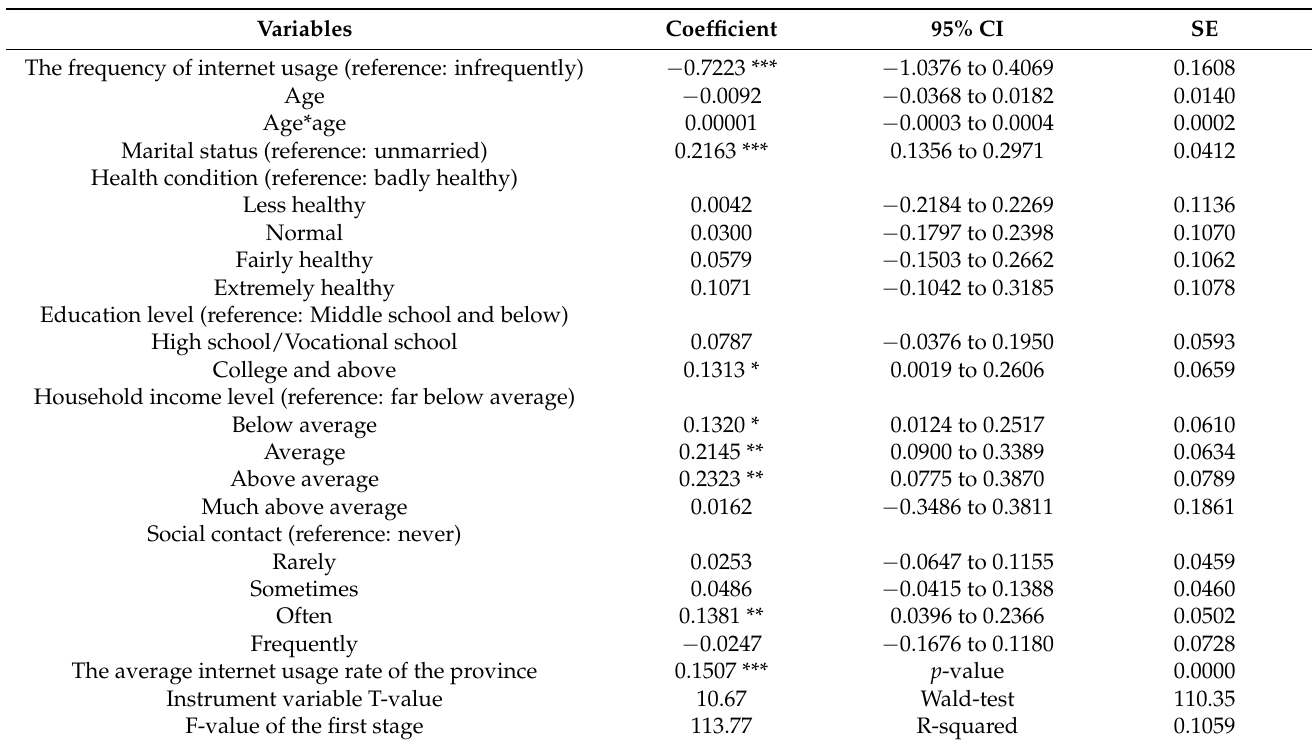
Table 3. Endogeneity test of the influence of internet usage frequency on female fertility